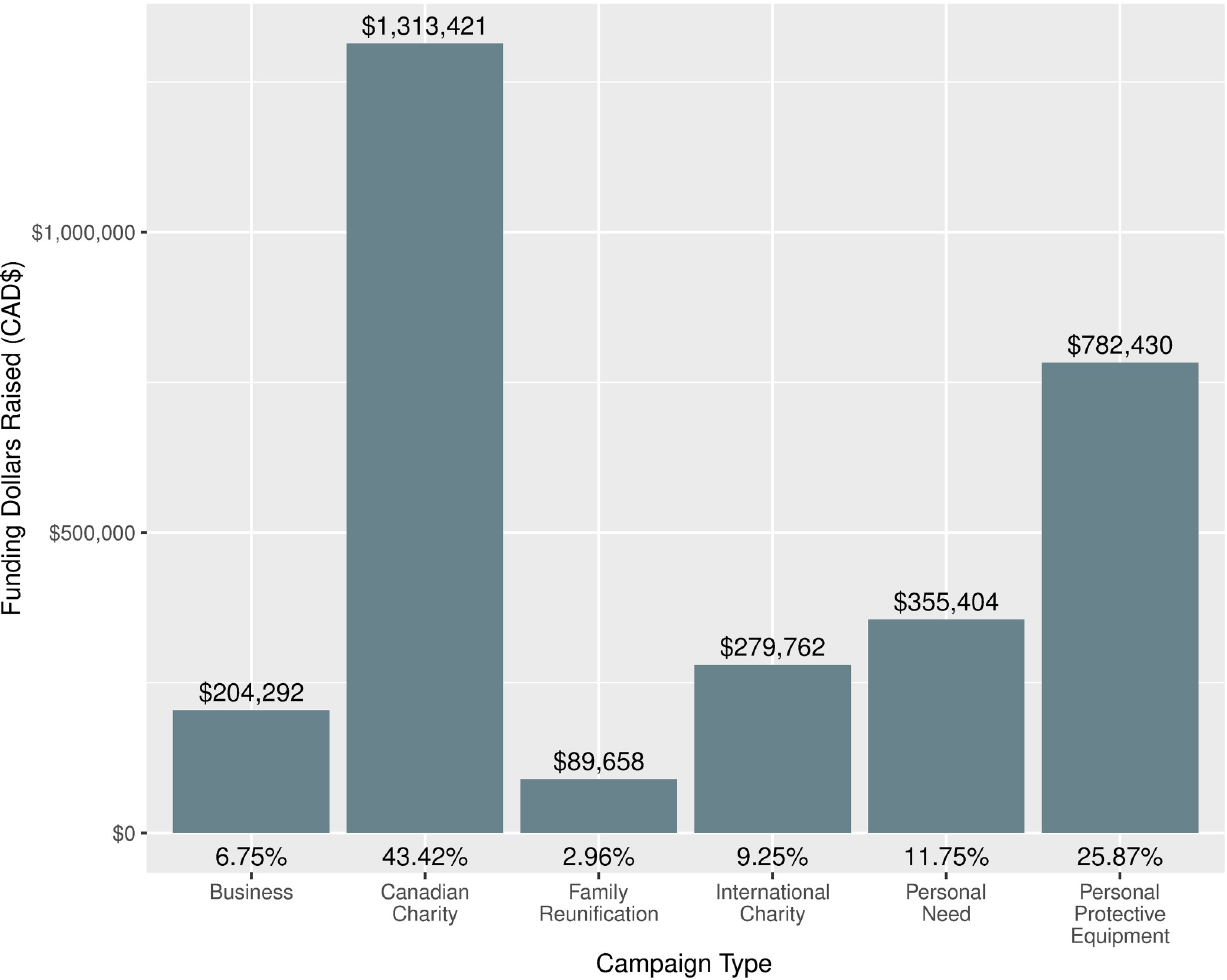
Fig 6. Dollars and proportion of total funding raised by campaign type. The dollar value atop each bar indicates how many dollars were raised by campaigns of the corresponding type, cumulatively. The percentage figure below the bar shows what proportion of total dollars raised by campaigns in the sample each dollar amount corresponds to (N dollars raised = $3 , 024 , 967)